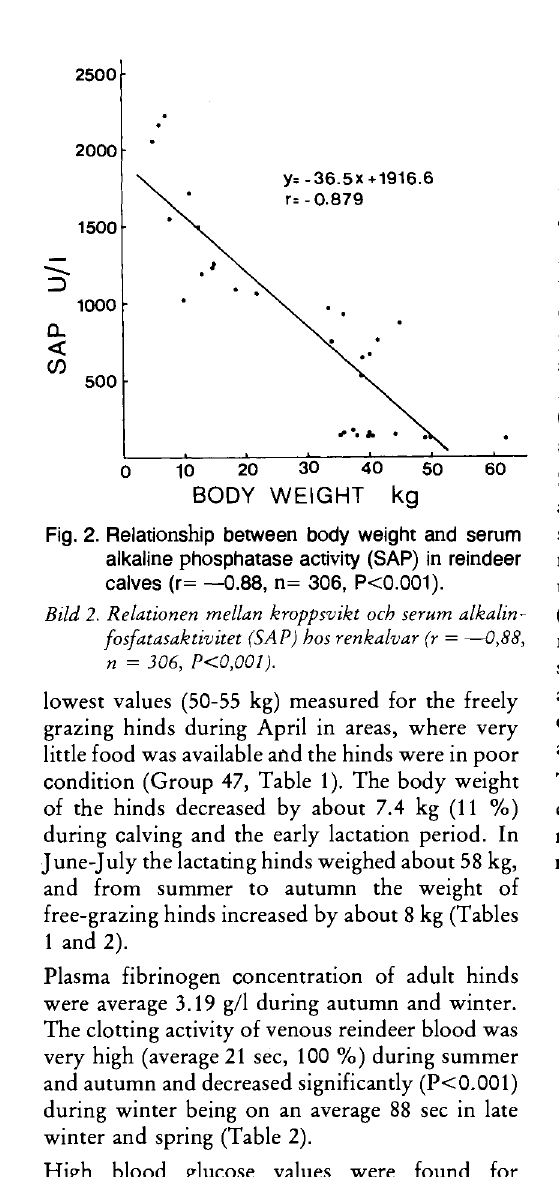
Fig. 3. Relationship between serum total protein and globulin concentrations in reindeer calves and hinds (r= 0.93, n= 251,